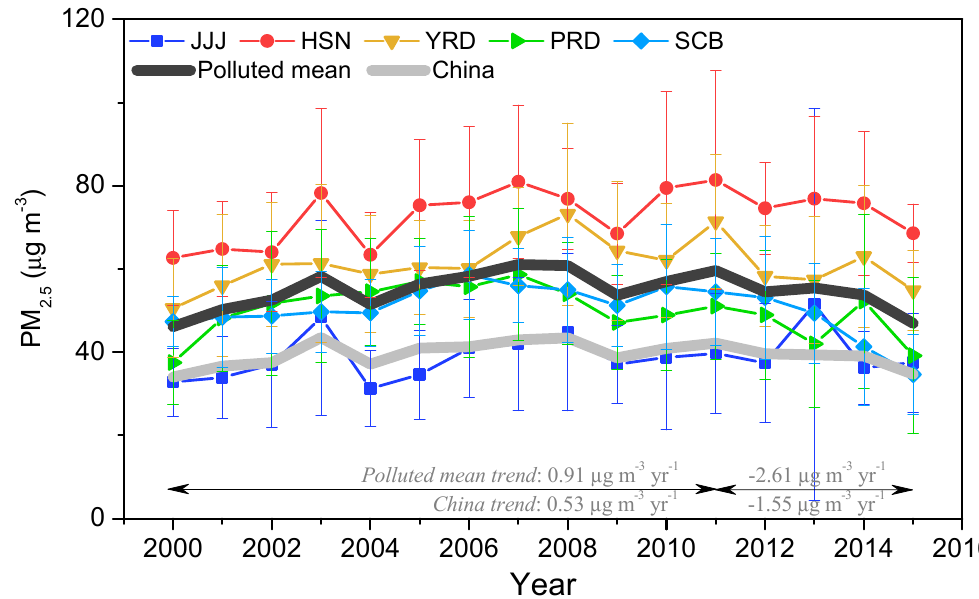
Figure 7. Time series of annual mean PM 2.5 mass concentrations over China, for five selected regions, indicated in the legend at the top, for 2000 to 2015. The polluted mean is the average over all five regions. Error bars indicate the standard deviation of the monthly mean. Trends are indicated at the bottom of the figure.